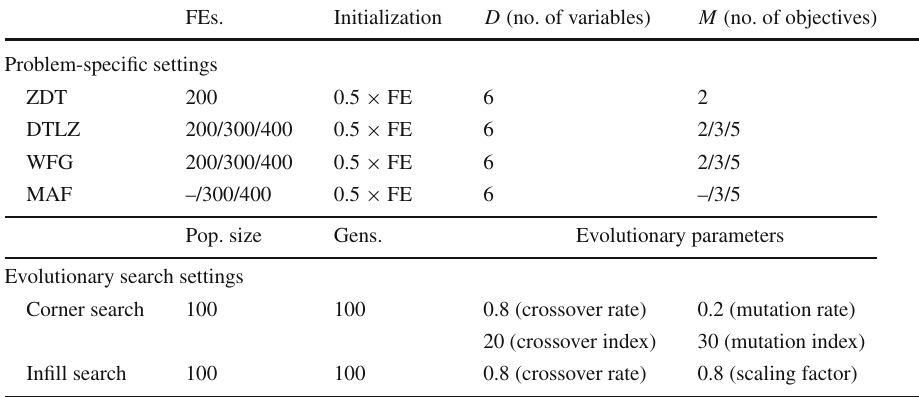
Table 1 Settings for numerical experiments